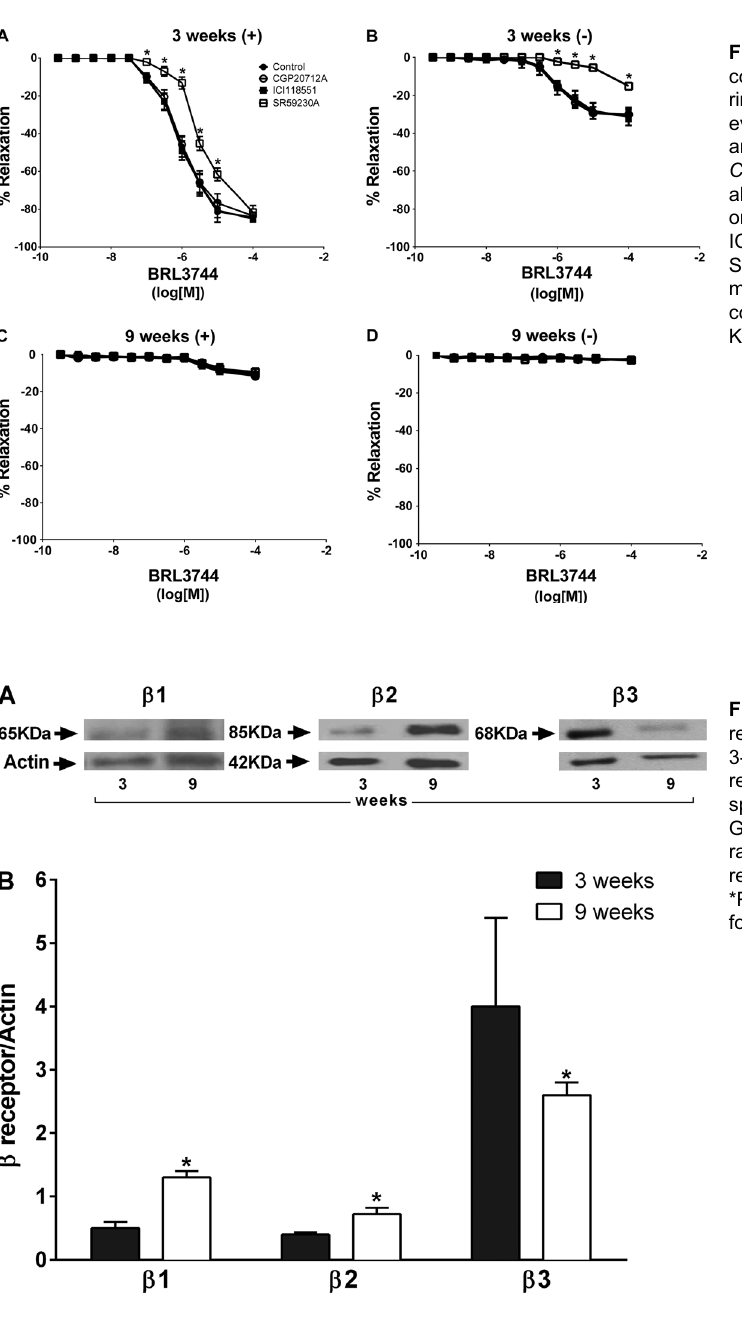
expression levels of b 3AR were lower in vascular tissue of 9-week-old rats compared with that in 3-week-old rats (Figure 4A and B). No differences were observed in b 2AR receptor phosphorylation under basal conditions or after isoproterenol stimulation in vascular tissue of younger and older rats (Figure 5A and B).